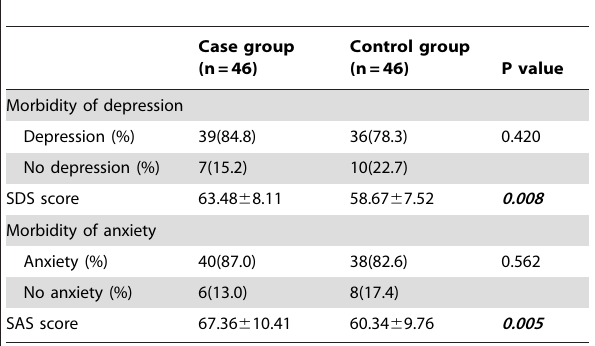
Table 4. Excluded variables b .